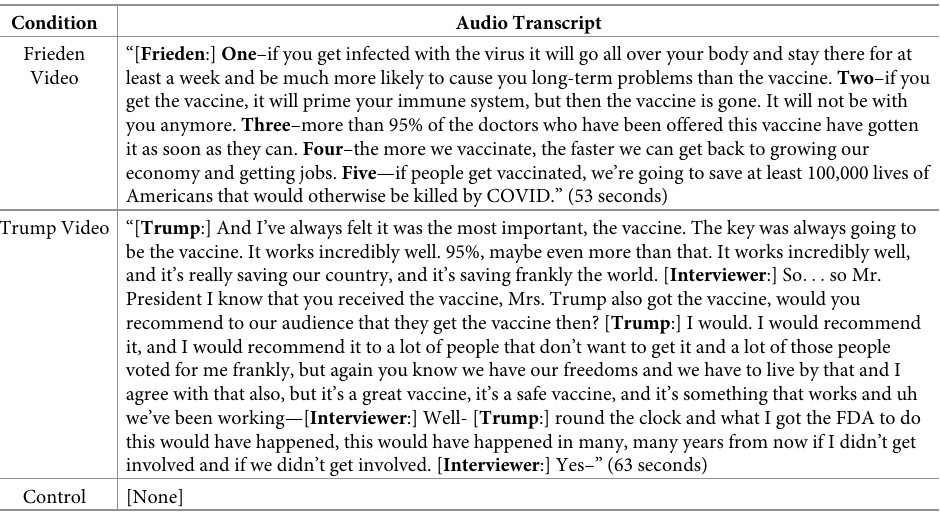
Table 2. Experimental